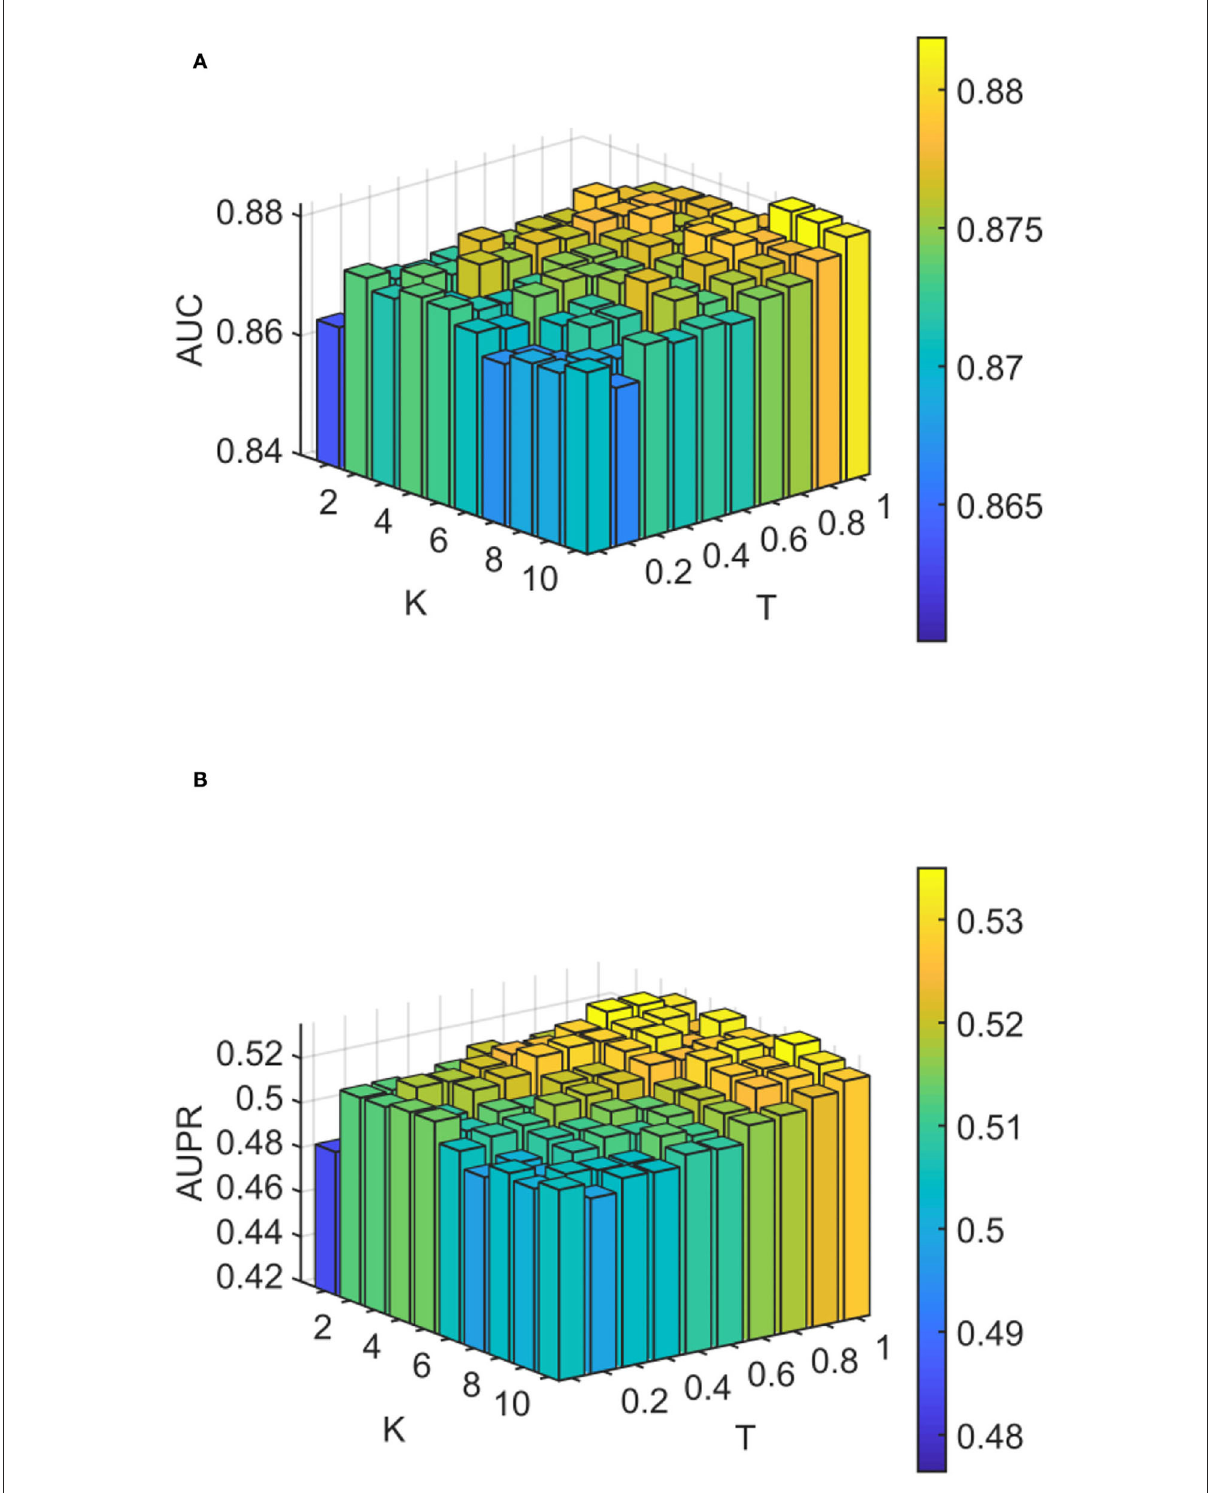
FIGURE3 Analytical plots of AUC and AUPR for K and T in the weighted K-nearest known neighbors (WKNKN) algorithm. (A) Analytical plots of AUC for K and T . (B) Analytical plots of AUPR for K and T